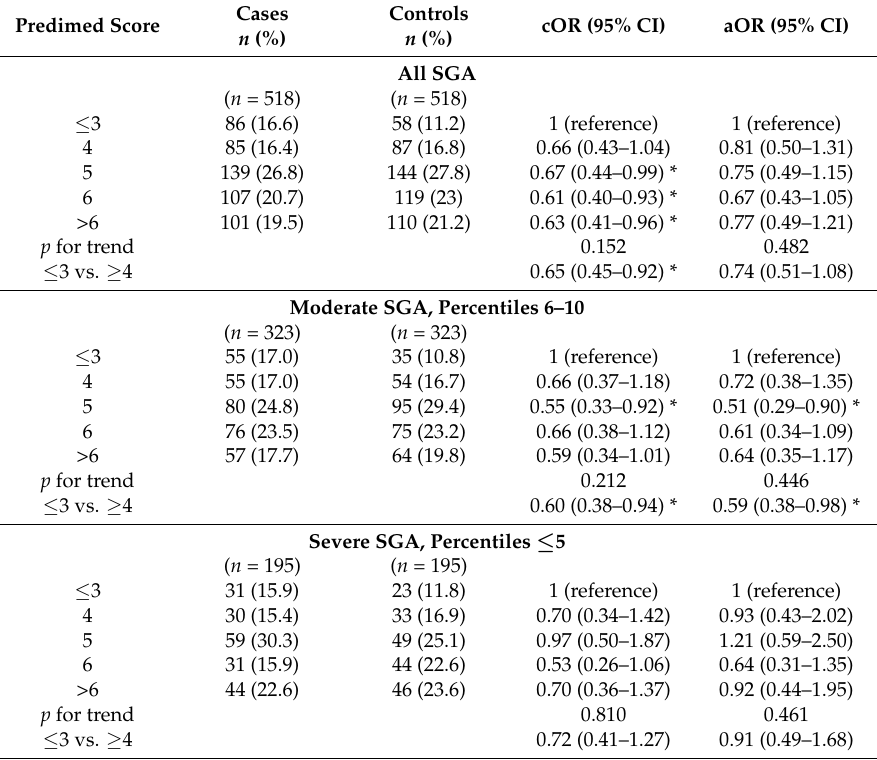
Table 3. Total Predimed score and risk of SGA for the entire sample and stratified on degree of